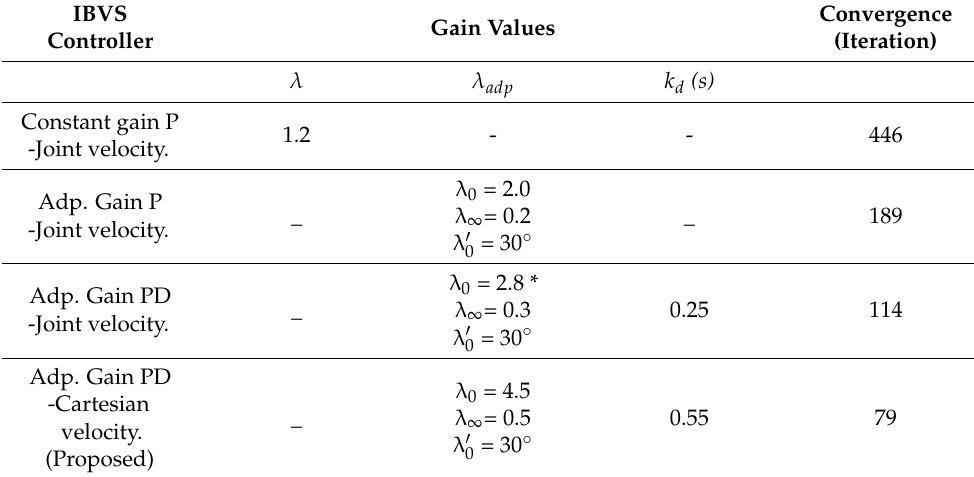
locity. Table 3. Effects of adaptive gain on the convergence rates of IBVS